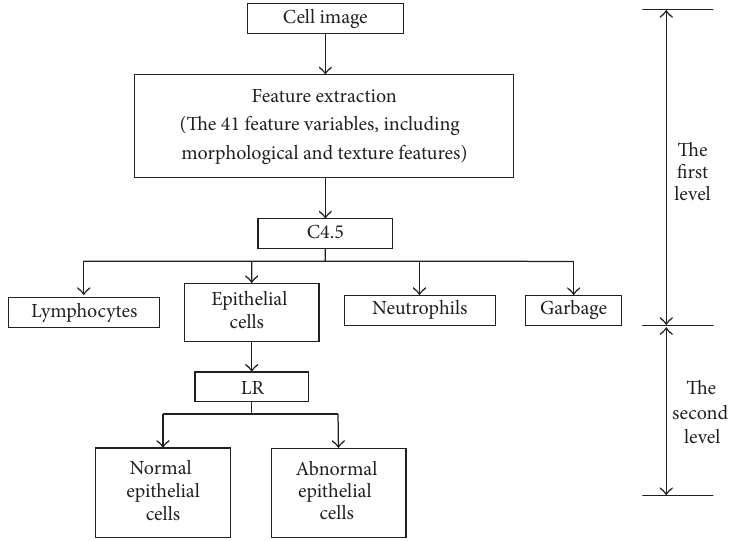
Figure 3: Flowchart of the two-level classification